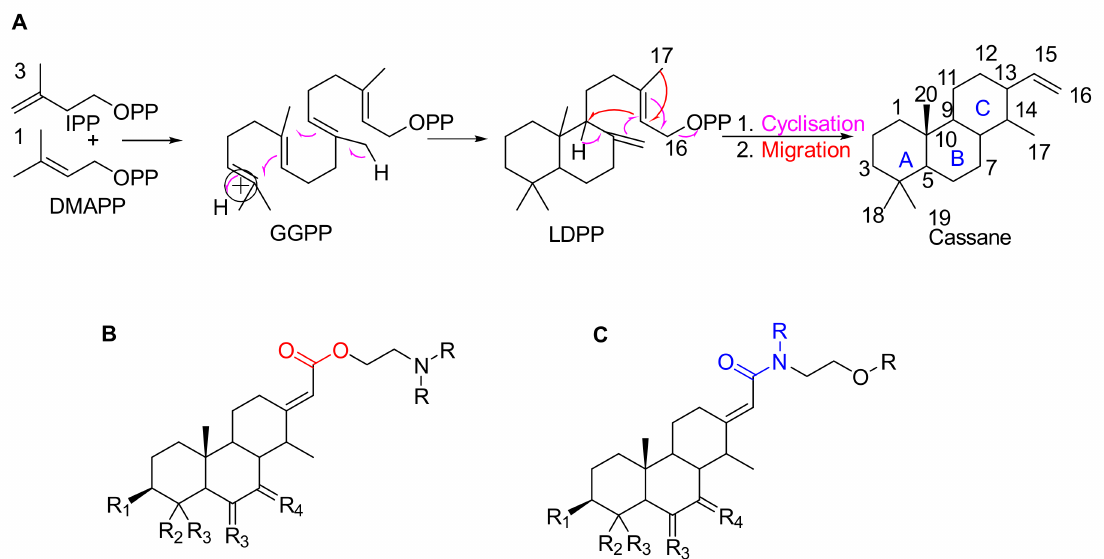
Figure 1. ( A ) Possible biosynthesis pathways for basic skeletons of cassane-types diterpenoids. Three molecules of isopen- tenyl pyrophosphate (IPP) react with a dimethylallyl pyrophosphate (DMAPP) which form geranylgeranyl pyrophosphate (GGPP) in the mevalonate pathway. The latter rearrange into ∆ 8 ,15-labdadienyl pyrophosphate (LDPP) which itself rear- ranges into cassane-type diterpene via cyclisation and migration. ( B , C ) Basic skeletons of cassane-type diterpenes with ( B ) an ester or ( C ) amide arm where R substituents are H, Me or any chain and